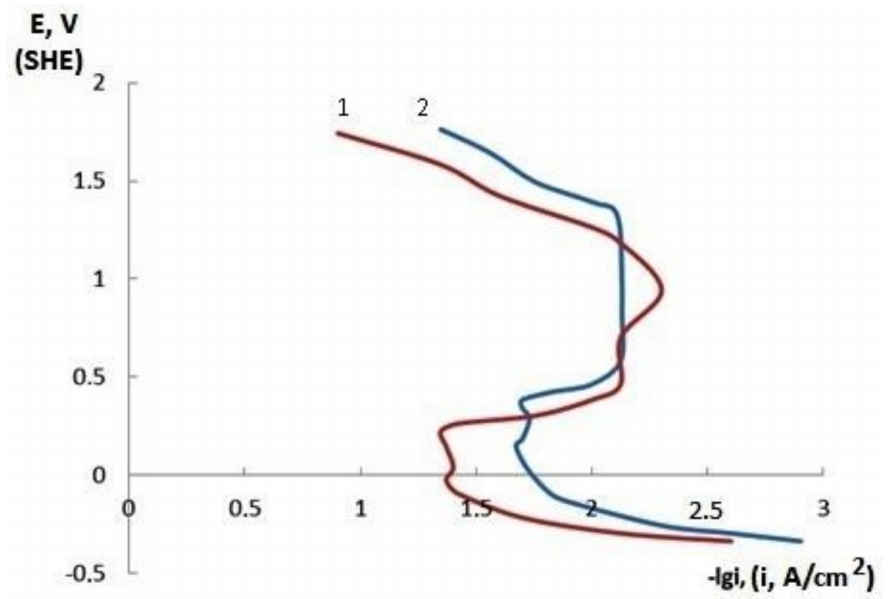
Figure 5. Potentiodynamic polarization curves of nickel (1) and nickel–GO CEC (2) in 0.5 M H 2 SO 4 (coatings were obtained at the time ratio of the cathodic and anodic periods t c /t a = 16:1).